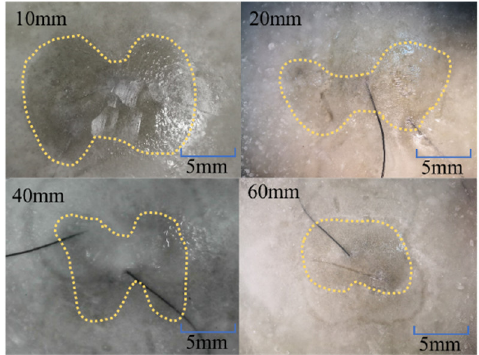
Figure 8. Deicing effect of specimens at different heights.